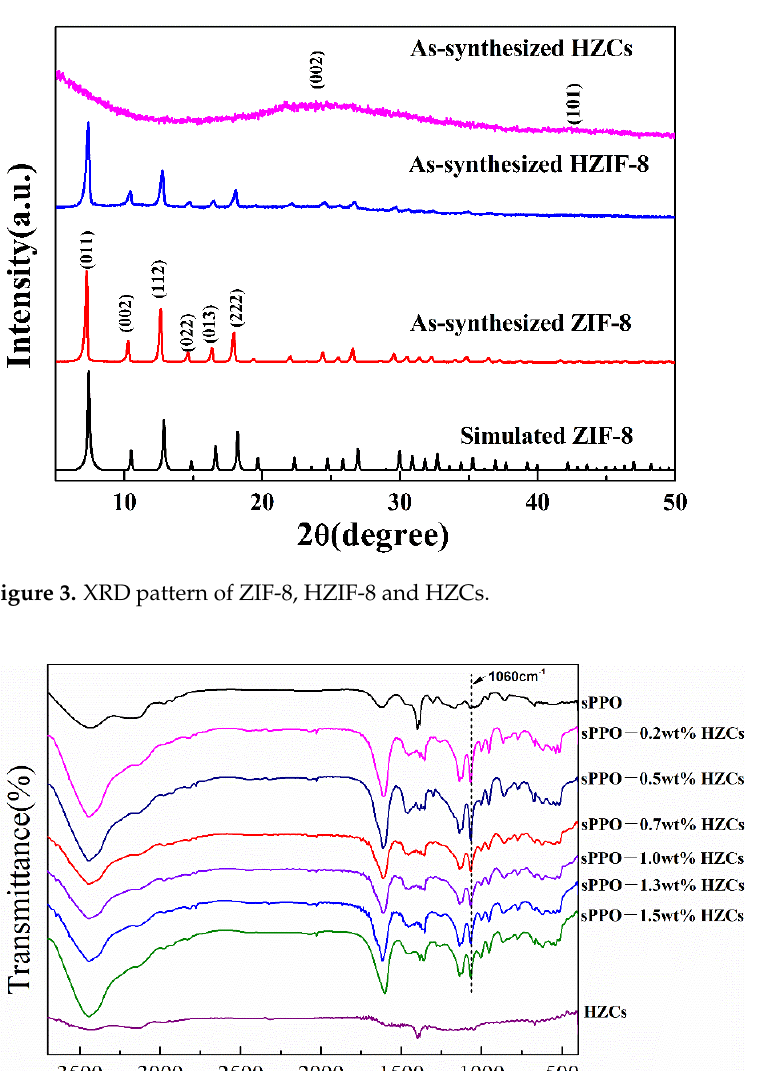
Figure 5. TGA of the membranes before and after HZCs loading (1.0 wt.% HZCs). The mechanical properties of the membranes at different HZCs loadings are shown in Figure 6.